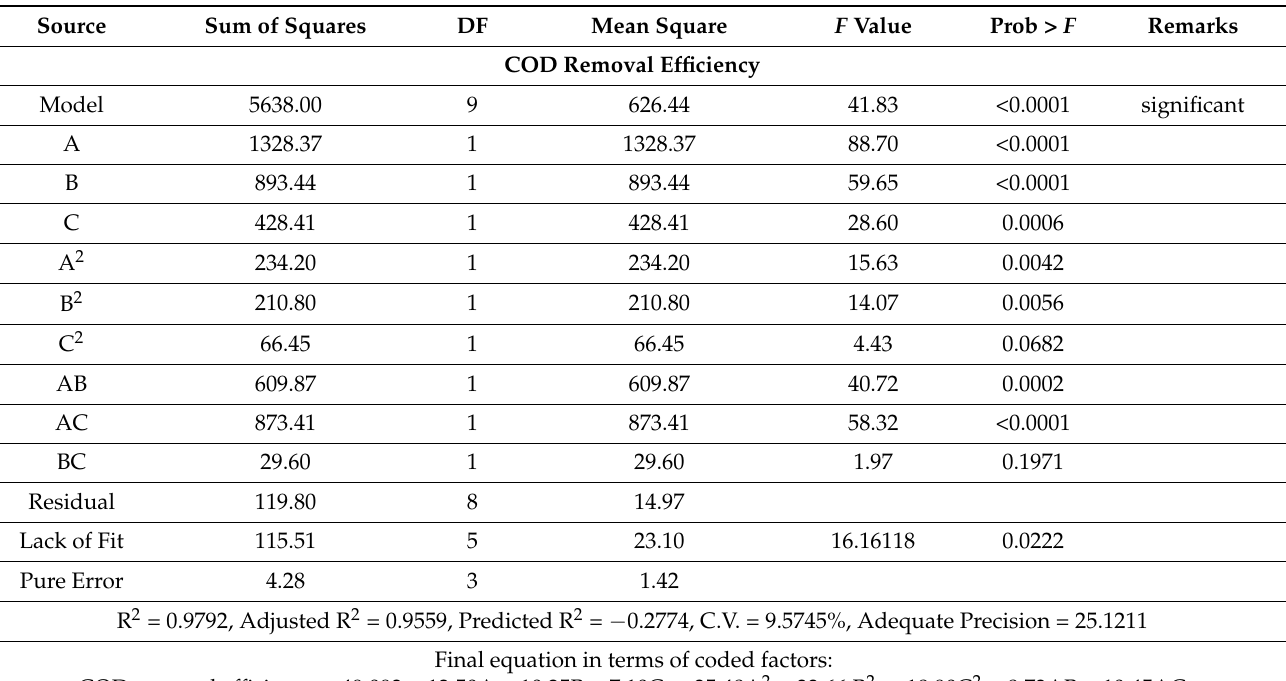
Table 3. ANOVA results for validating response surface quadratic models for COD removal.